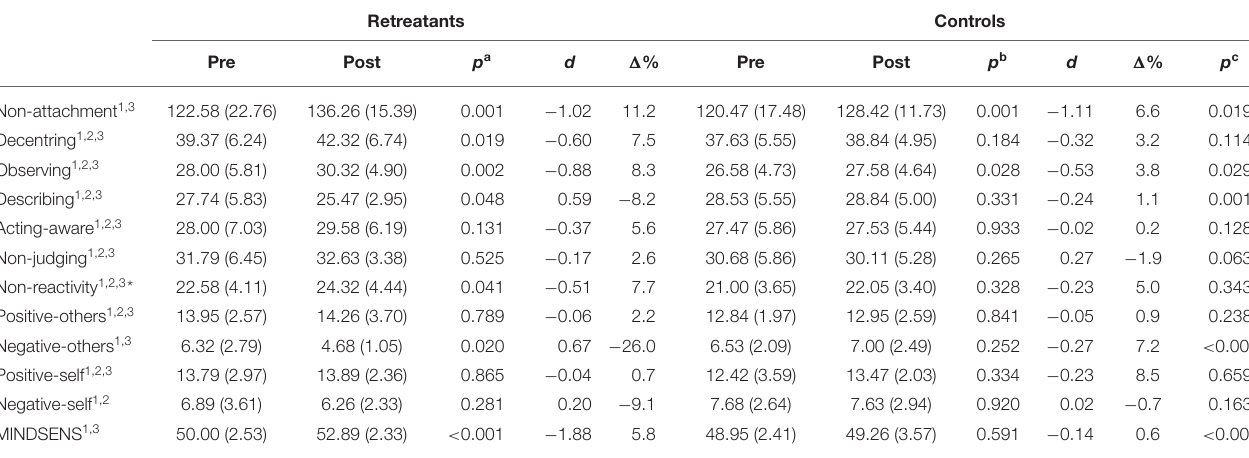
TABLE 2 | Meditation retreat effects on mindfulness variables.